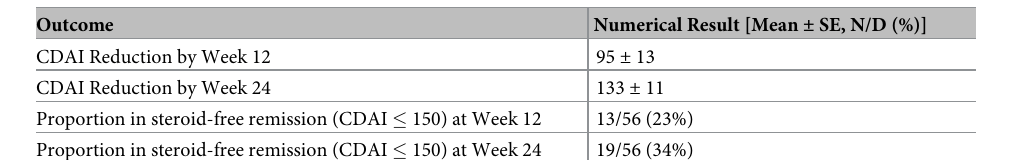
Table 8. Efficacy